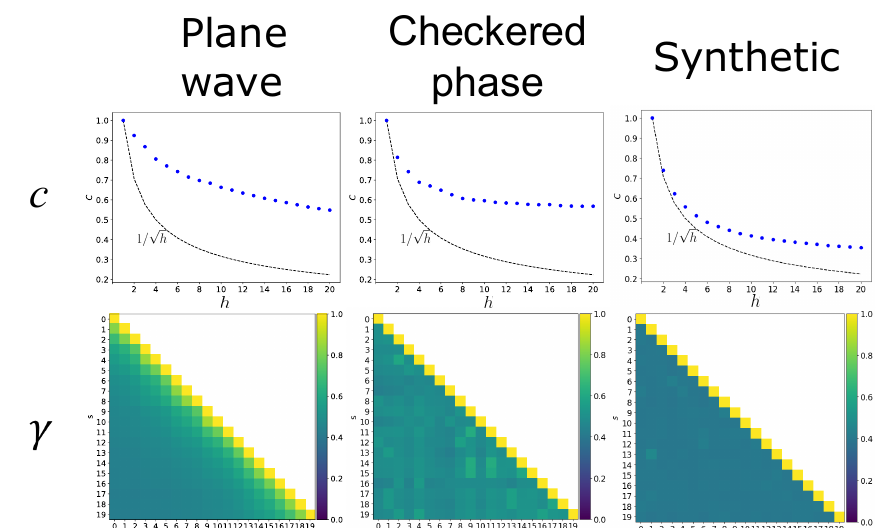
Figure 7. Behavior of the speckle metrics for the three methodologies. First row: speckle coefficient for the square region indicated in Figure 6. Second row: correlation coefficients for every image